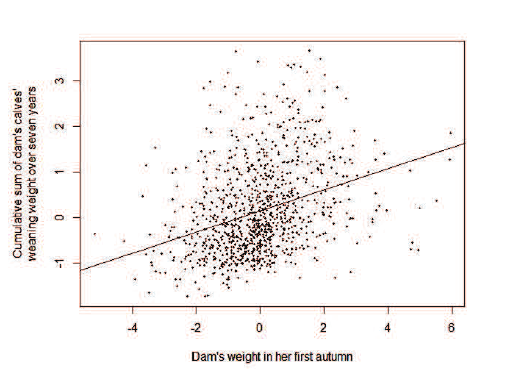
Standard errors are given in the parentheses .